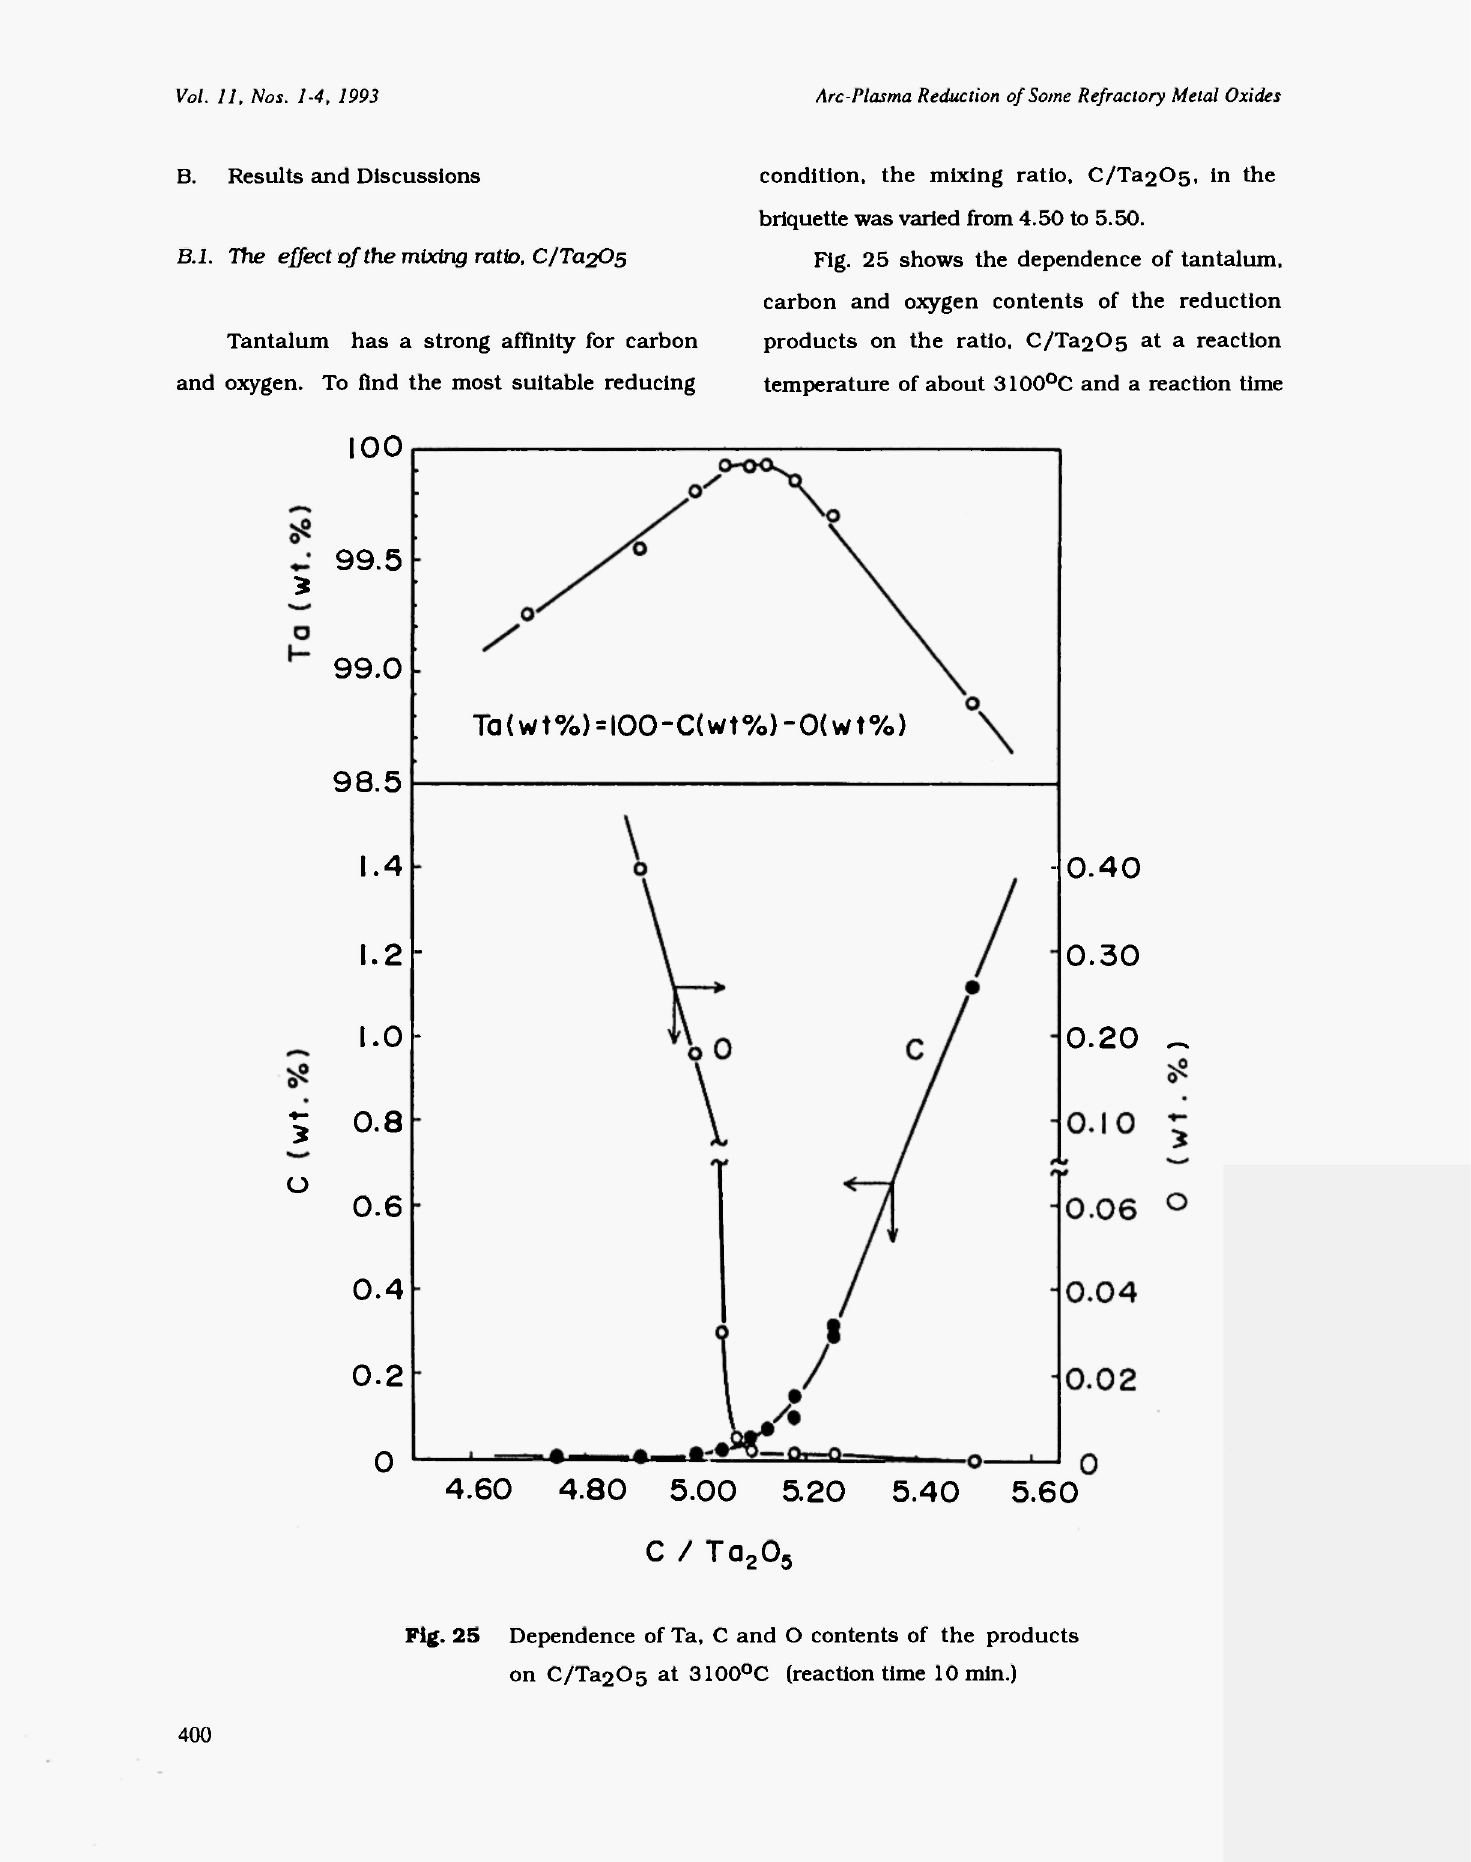
Fig. 25 Dependence of Ta, C and Ο contents of the products on C/Ta2C>5 at 3100°C (reaction time 10